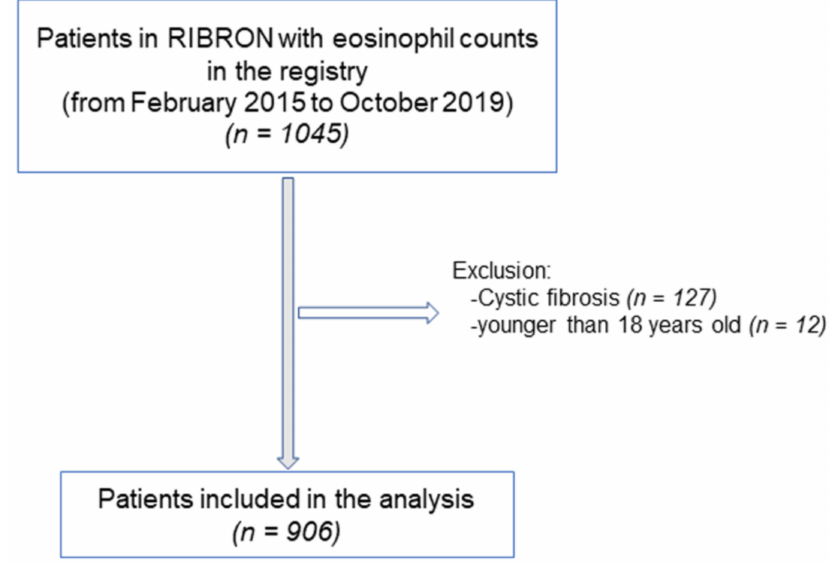
Figure 1. Flowchart of the study